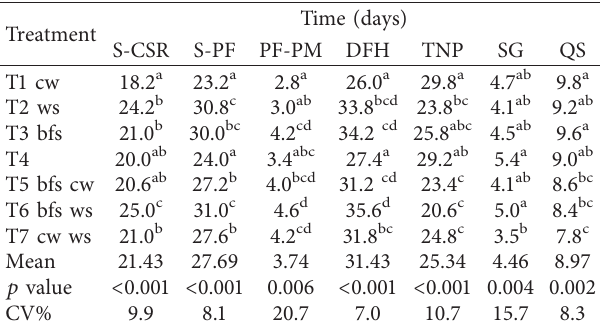
Table 2: The effect of different substrate treatments on mushroom growth parameters